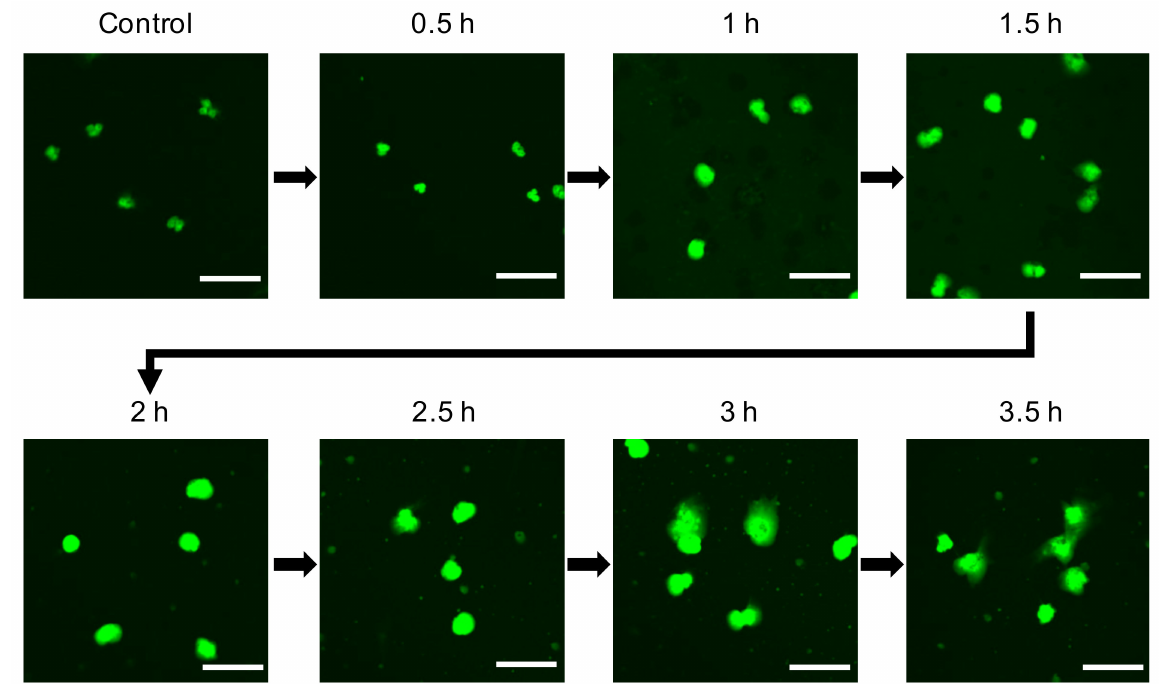
Figure 2. Decondensation of chromatin in 5 nm AgNP-treated neutrophils. Human neutrophils were treated with 1.6 µ g/mL 5 nm AgNPs on poly- L -lysine-coated chamber slides for each indicated time point and fixed with 4% paraformaldehyde. The DNA of cells was stained with SYTOX Green. Scale bar: 20 µ m. This experiment was performed in duplicate and repeated three times with different